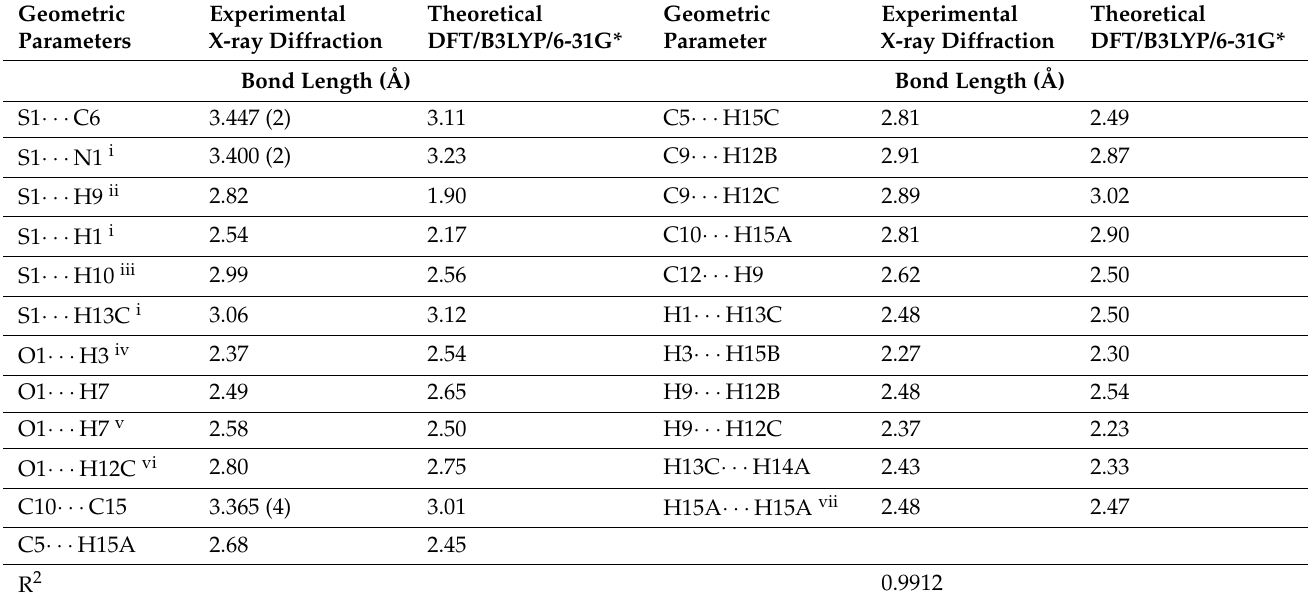
Table 1. Interatomic distances (Å) obtained via X-ray diffraction and